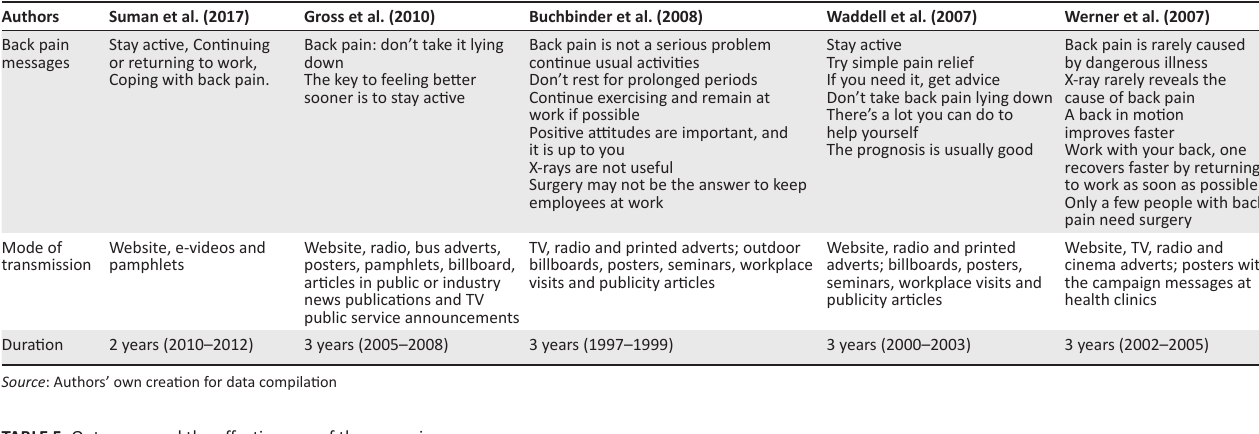
TABLE 5: Outcomes and the effectiveness of the